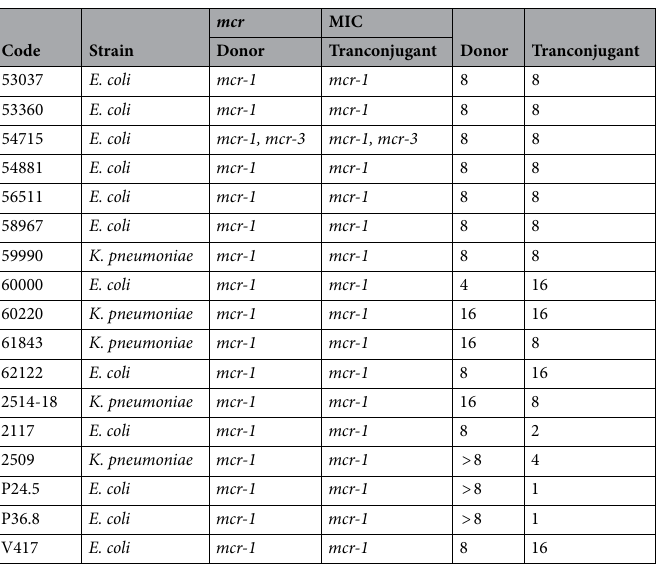
Table 3. Profiles of antimicrobial-resistance genes of donors E. coli , K. pneumoniae and tranconjugants.